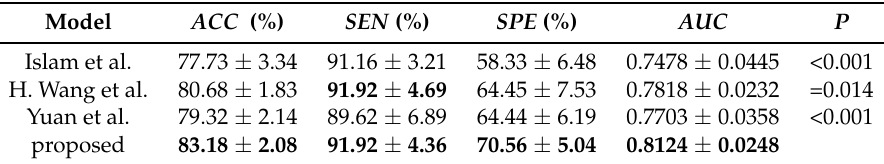
Table 16. Classification performance of different methods for T2